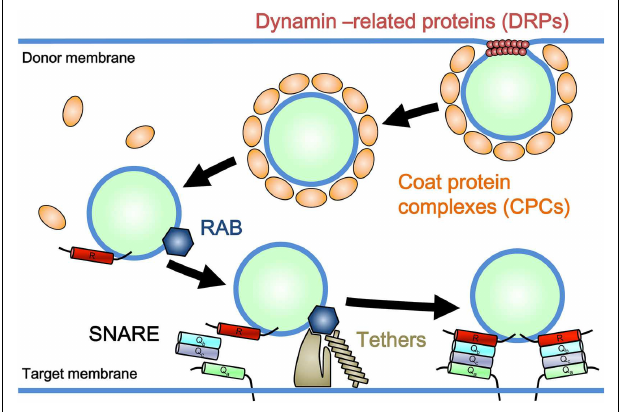
FIGURE 1 | Model for a general mechanism of membrane trafficking. Coat protein complexes (CPCs) and dynamin-related GTPases (DRPs) participate in the formation of vesicular or tubular carriers. CPCs facilitate cargo selection and membrane deformation, and DRPs take part in the tubulation and/or scission of donor membranes. Rab GTPase promotes the tethering of membrane carriers to the target membrane through effector molecules (Tethers), which is followed by SNARE-mediated membrane